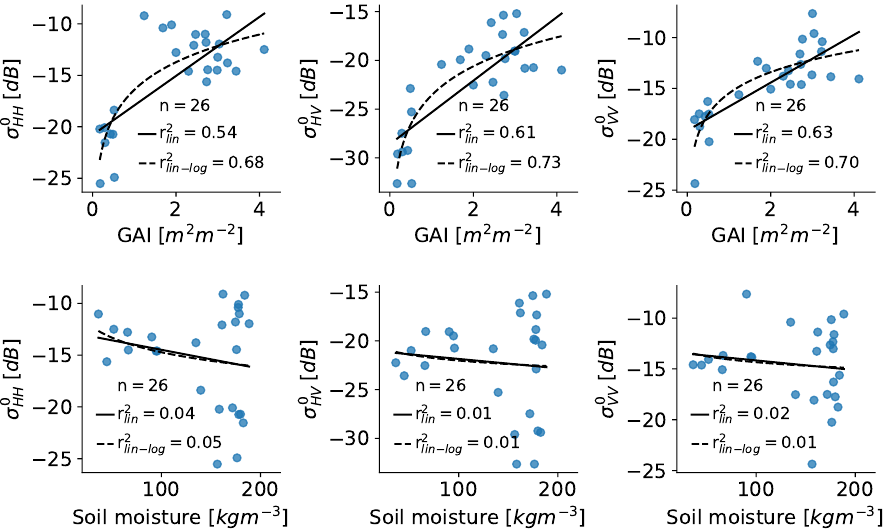
Figure 6. Scatter plots, as well as linear and linear-log regressions lines, of the volumetric surface soil moisture and GAI as a function of the backscattering coefficient σ 0 in HH, HV, and VV